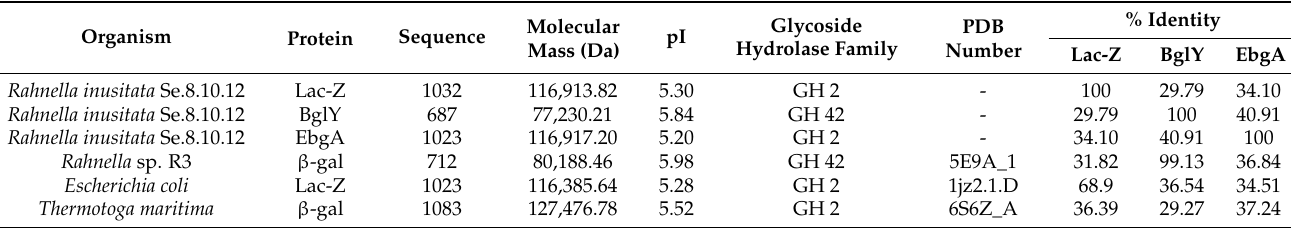
Table 2. Biochemical properties of Rahnella inusitata Se.8.10.12 β -galactosidases and other β -gal enzymes from PDB database. Organism Protein Rahnella inusitata